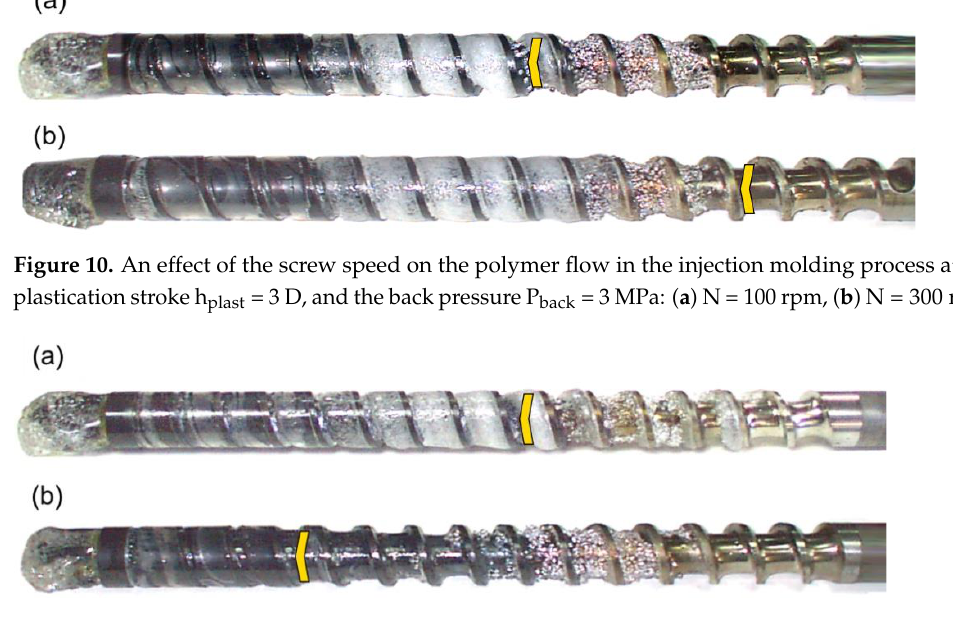
Figure 13. An effect of the plastication stroke on the polymer flow in the injection molding process at the screw speed N = 300 rpm, and the back pressure P back = 0 MPa: ( a ) h plast = 1 D, ( b ) h plast = 3 D. Figure 14. An effect of the plastication stroke on the polymer flow in the injection molding process at the screw speed N = 300 rpm, and the back pressure P back = 2 MPa: ( a ) h plast = 1 D, ( b ) h plast = 3 D. Figure 15. An effect of the plastication stroke on the polymer flow in the injection molding process at the screw speed N = 300 rpm, and the back pressure P back = 3 MPa: ( a ) h plast = 1 D, ( b ) h plast = 3 D.